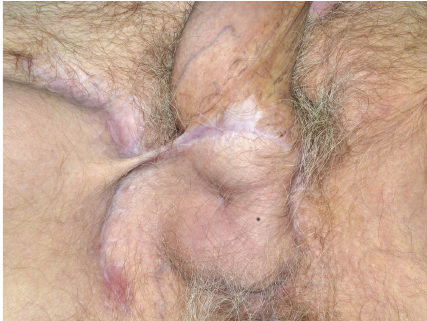
Figure 4: Perineal wound 5 months after radical scrotectomy, bilateral simple orchiectomy, and wound closure with pudendal thigh